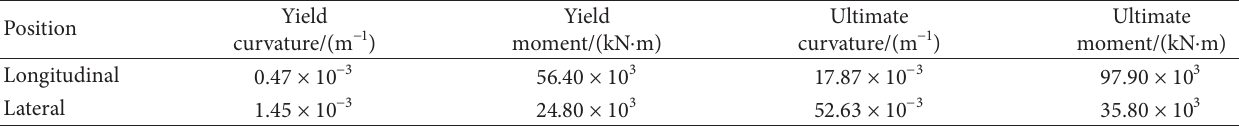
Table 8: Calculated values of skeleton-frame curves of moment-curvature relationship.